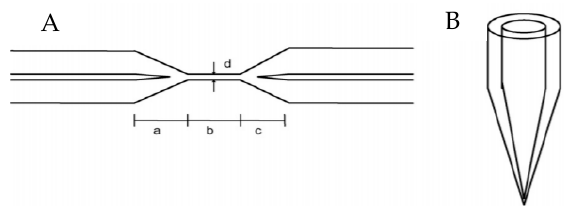
Figure 5. ( A ) Tapered optical fiber ( B ) Tapered tip [11].